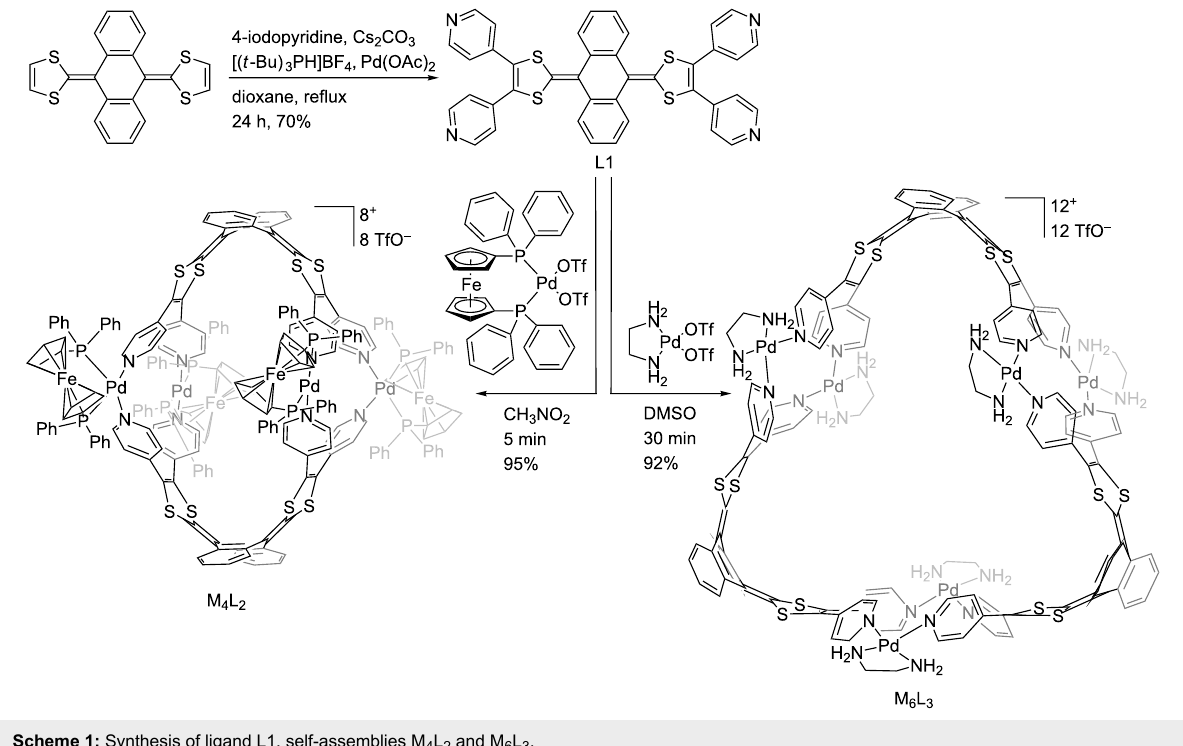
Scheme 1: Synthesis of ligand L1, self-assemblies M 4 L 2 and M 6 L 3